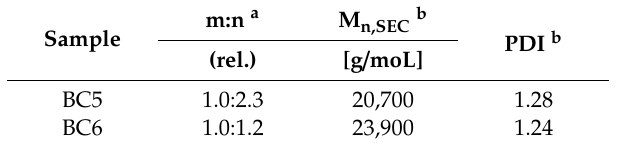
Table 9. Characterization of the synthesized PDHPA- b -PNIPAAm block copolymers.